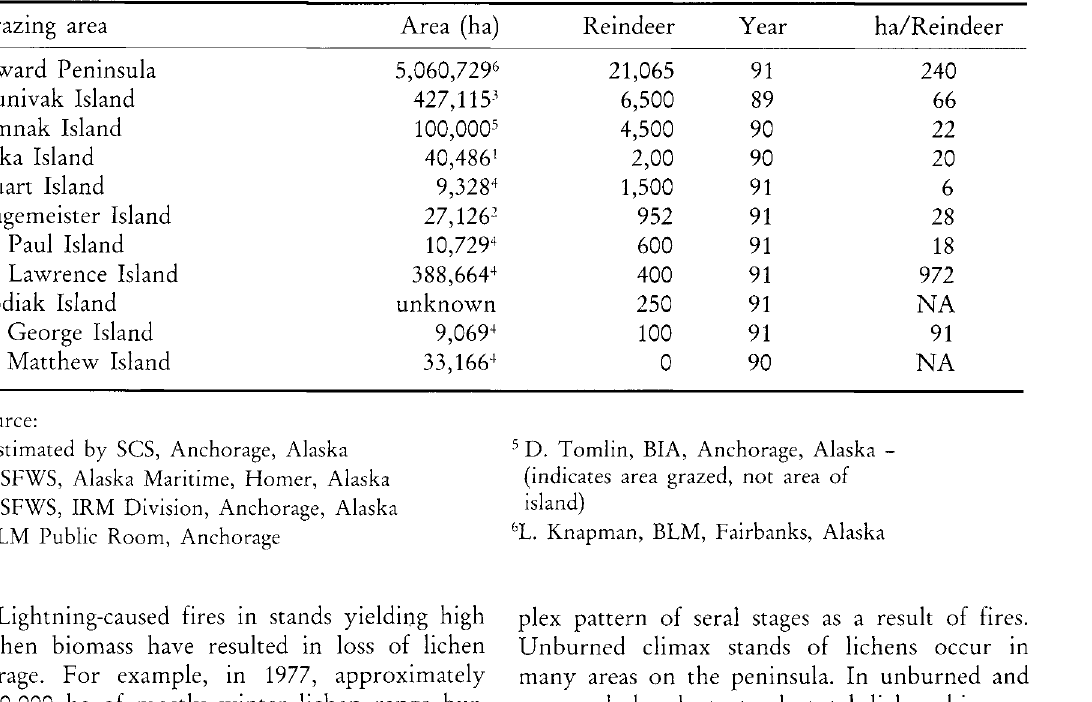
Table 2. Alaska reindeer grazing areas, reindeer populations and ha/reindeer. Grazing